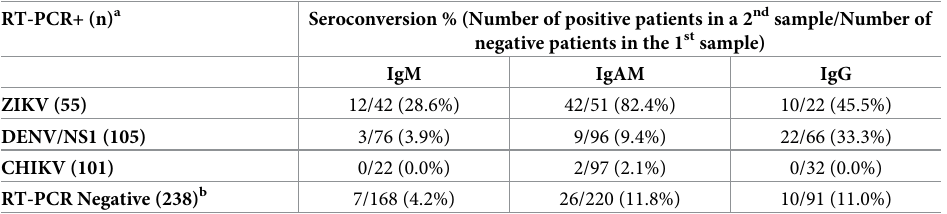
Table 3. Seroconversions for anti-ZIKV IgM, IgAM, and IgG in patients with paired